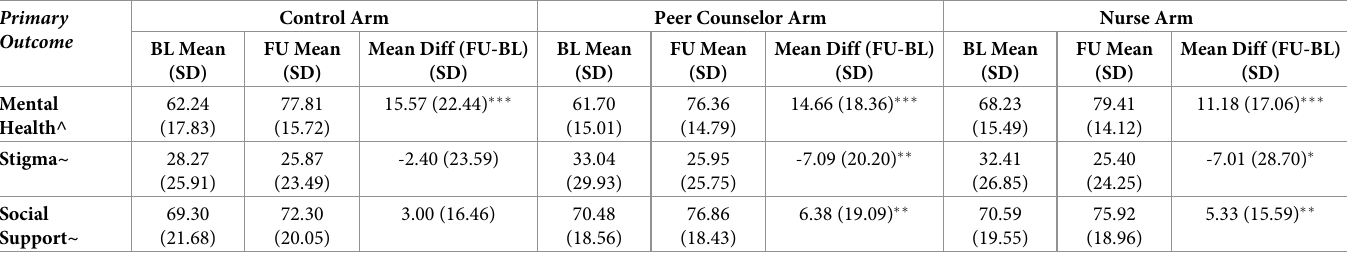
Table 2. Mean (standard deviation) mental health, stigma, and social support scores at baseline (BL) and follow-up (FU). Primary Outcome